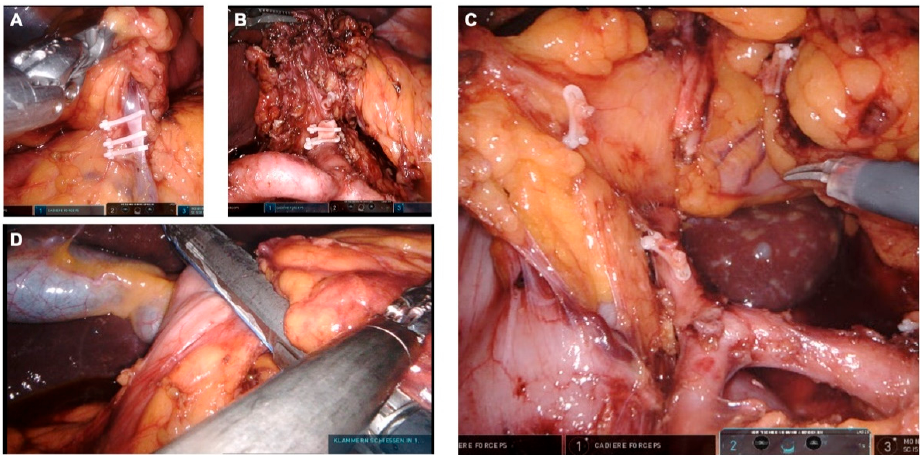
Figure 3. Lymphadenectomy. ( A ) Exposure of the right gastroepiploic vein. ( B ) Exposure of the celiac trunc, the common hepatic artery, the splenic artery. The left gastric artery has been divided. ( C ) Exposure of the gastroduodenal artery, the common hepatic artery and the proper hepatic artery. The right gastric artery has been divided. ( D ) Closure of the duodenal stump.